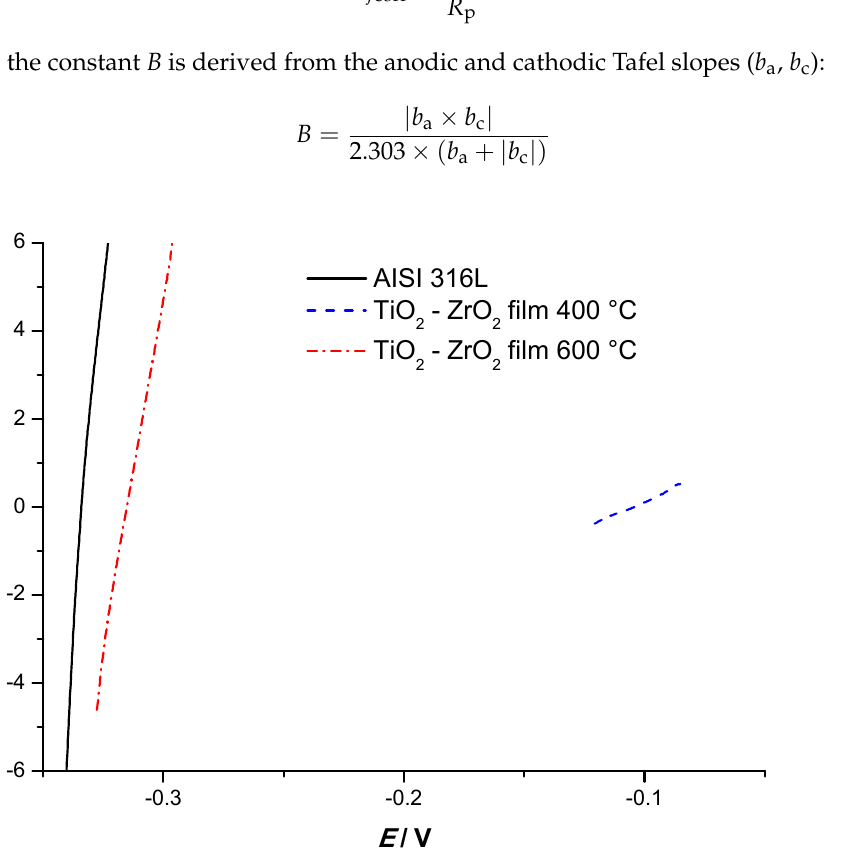
Figure 7. Polarization curves measured in 0.5 mol dm − 3 HCl solution for uncoated AISI 316L stainless steel and coated with sol–gel TiO 2 –ZrO 2 film annealed at 400 ◦ C or 600 ◦ C. Table 4. Values of open-circuit potential ( E oc ) measured in 0.5 mol dm − 3 HCl solution (mean value ± standard deviation).